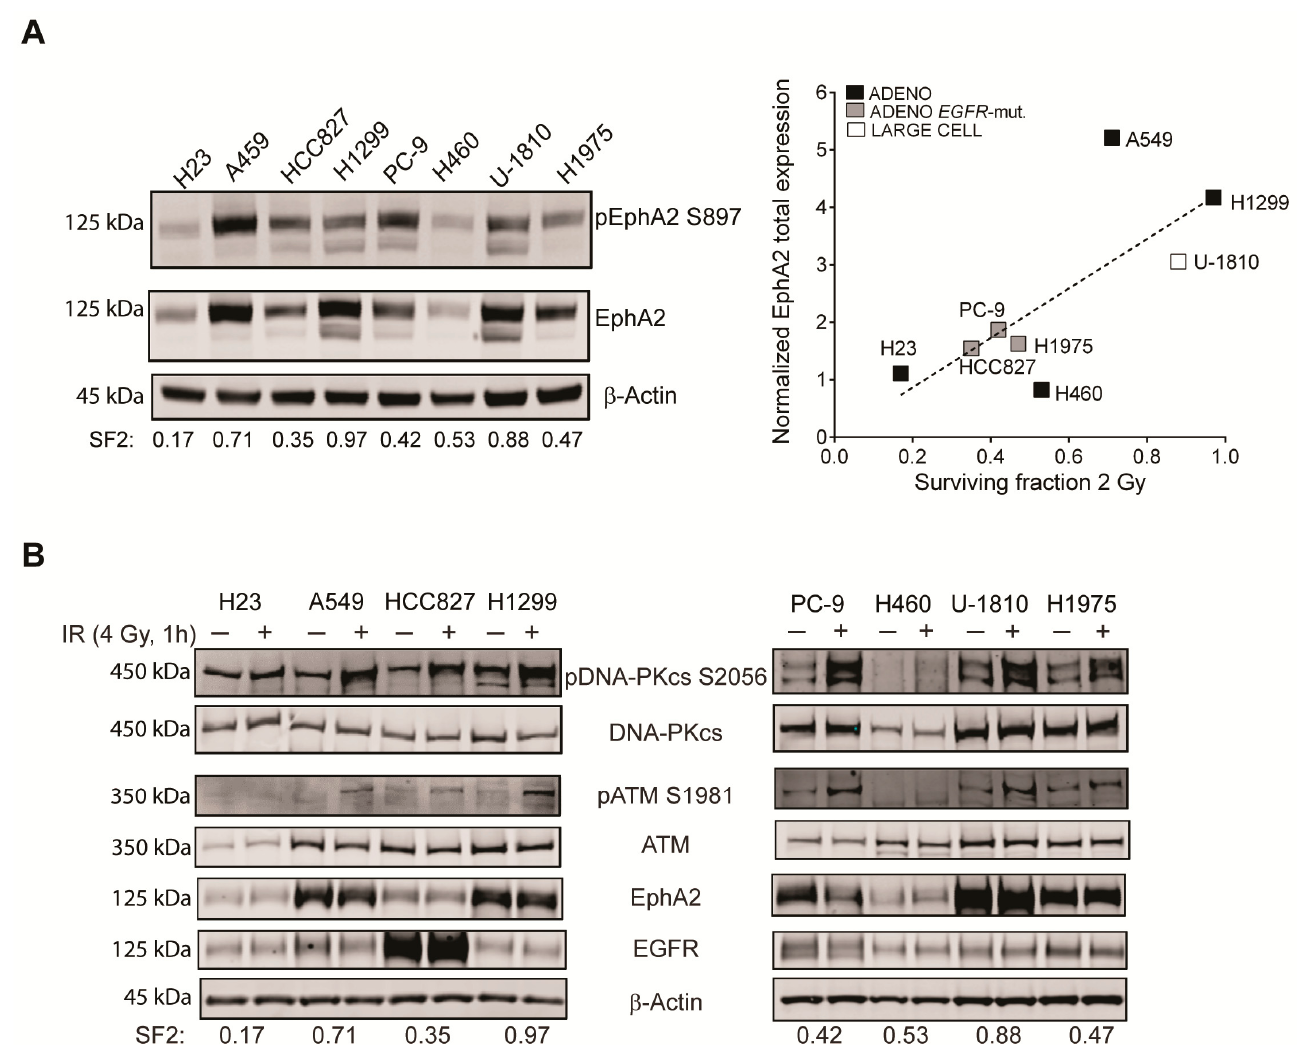
Figure 1. Expression and phosphorylation of EphA2 at S897 in NSCLC cells in relation to IR sensitivity and IR response. ( A ) The level of pEphA2 S897 or total EphA2 were studied by immunoblotting in a NSCLC cell line panel with β -Actin used as a loading control (blot shown corresponds to EphA2 total blot). Published SF2- values for the different cell lines are shown. Total EphA2 was quantified and expression given after correction for loading differences. This data was analyzed in relation to SF2 values. ( B) NSCLC cell lines were profiled at baseline or 1 h post IR (4 Gy) for phosphorylation of DNA-PK cs at S2056, ATM at S1981, or expression of total DNA-PK cs , ATM, EphA2 and EGFR. To control for loading differences β -Actin was used.